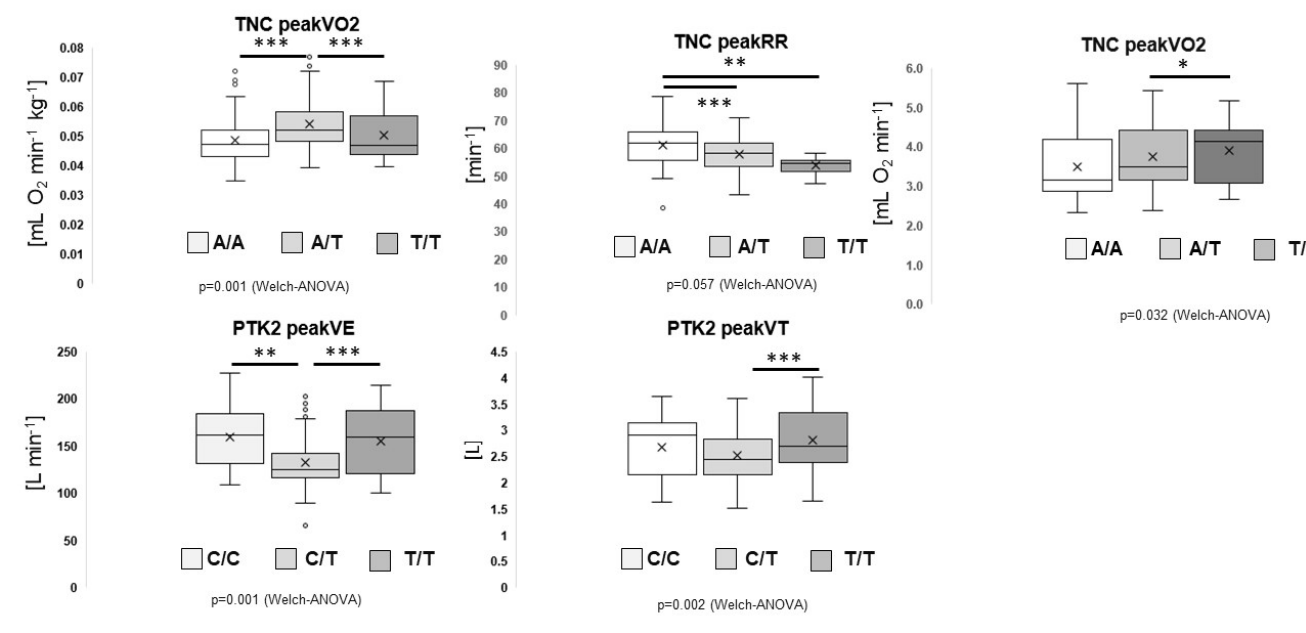
Figure 4. Main genotype associations with cardiorespiratory parameters. Box-whisker plots for absolute and body-mass-related peak VO 2 and peakRR for TNC (rs2104772) genotypes and peakVE and peakVT for PTK2 (rs7843014) genotypes. ANOVA with post hoc test of least significant difference. The corresponding p -values for the Welch type ANOVA are indicated below each panel. *, ** and *** indicate, p ≤ 0.05, 0.01 and 0.001, respectively, for the indicated comparisons.